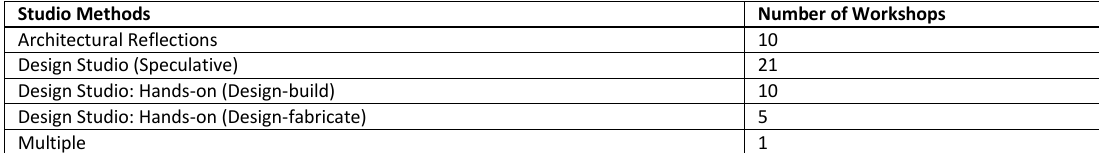
Table 11 Tables representing the number of workshops across ISAD tactics: Studio